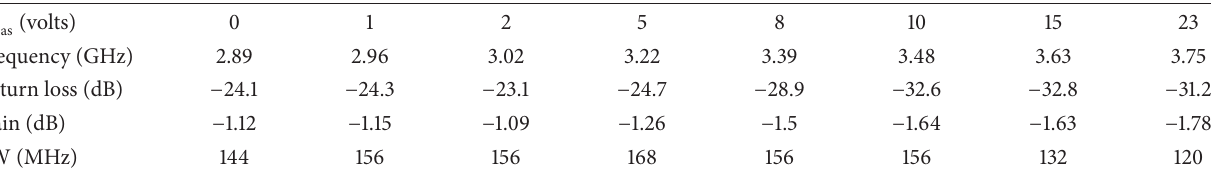
Table 1: Performance of the tunable dual-band antenna with fixed 1.8GHz, variable 𝐶 1 = 0.56 pF, 𝐶 2 = 0.68 pF, 𝐿 1 = 0.2 nH, 𝐿 2 = 6.8 nH, = 0.47 pF, and 𝐿 = 3.9 nH. 𝐶 4 3